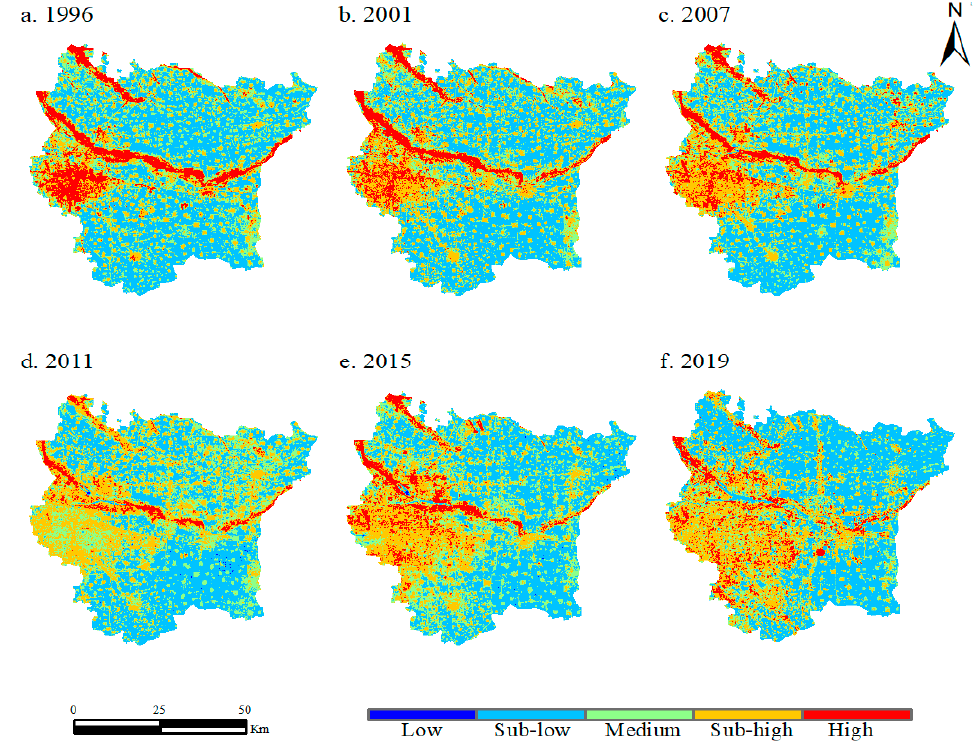
Figure 5. Distribution of heat levels from 1996 to 2019.